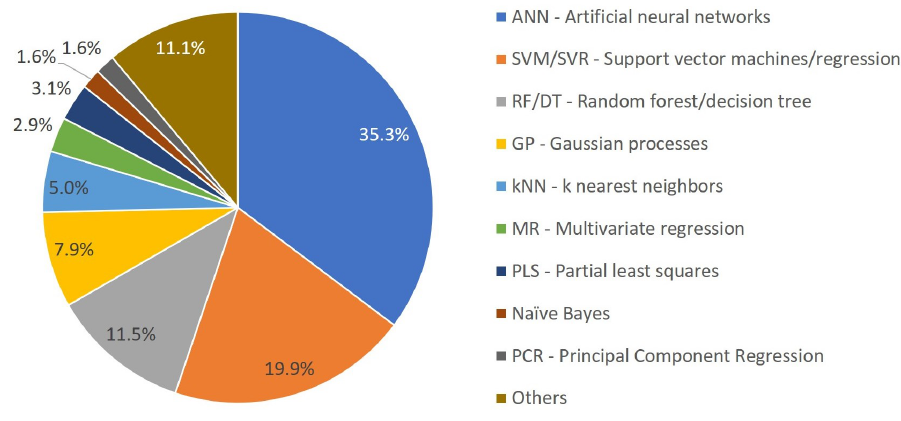
Figure 3. Distribution of supervised learning methods in the reviewed CPE